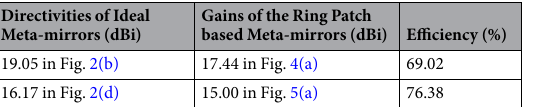
Table 3. Comparisons of the ideal meta-mirrors in Fig. 2 and the ring patch based meta-mirrors in Figs 4 and